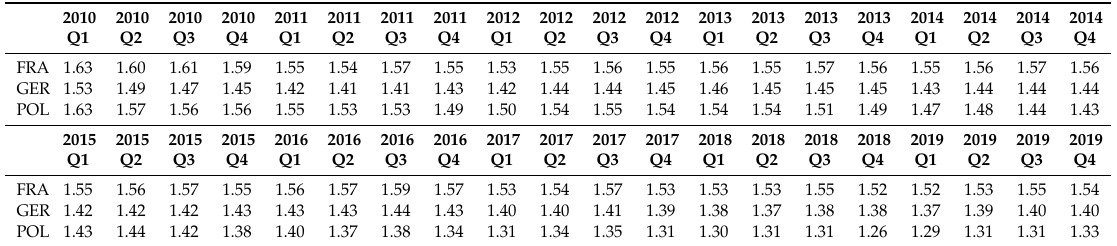
Table 7. Fiscal multiplier, own work, source: